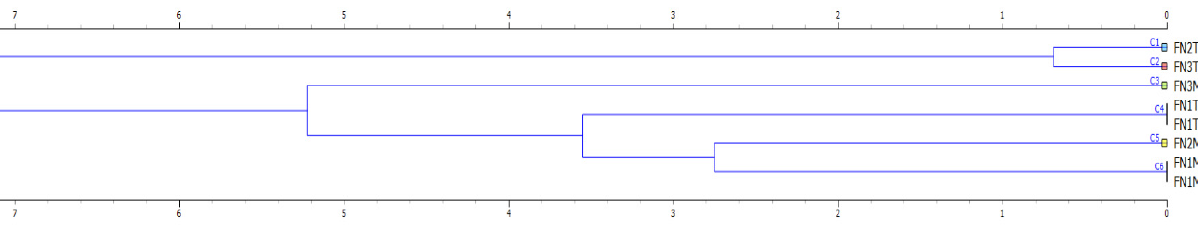
Figure 5. Dendrogram showing the hierarchical clustering of the forest nurseries, tillage systems and species based on the root collar diameter (target variable), as a function of physical properties of the soils before sowing (transplanting). Legend: abbreviations of the right side of the figure are explained in Table 3, horizontal axis stands for the Euclidian distance.